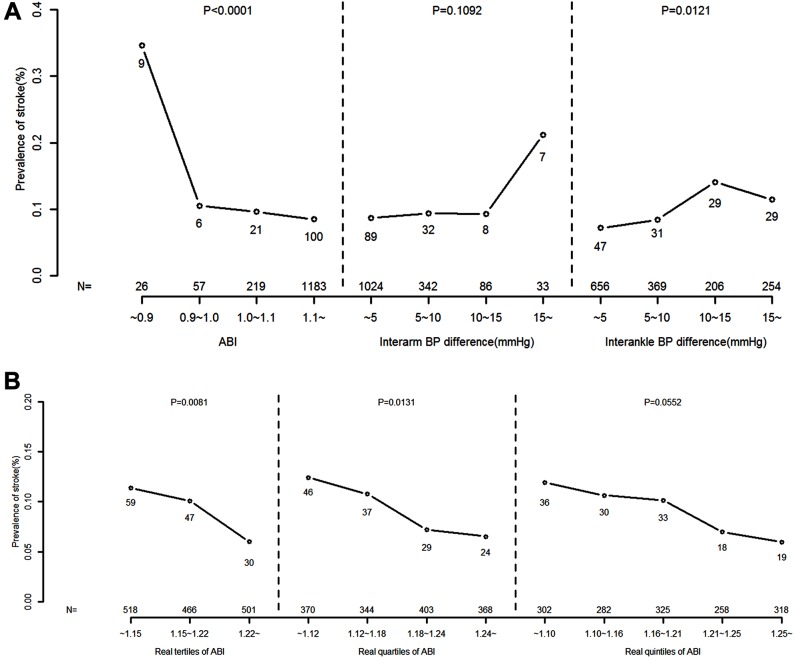
Prevalence of stroke stratified by the ankle-brachial blood pressure index (ABI) and interarm and interankle blood pressure (BP) differences.The numbers of strokes and participants are given alongside the symbols and at the bottom, respectively. P-values are given for trends in each group. A: The prevalence of stroke for different cutoff points of the ABI, interarm BP difference and interankle BP difference. Open circles represent the prevalence of stroke for ABI (left), interarm BP difference (middle) and interankle BP difference (right). B: The prevalence of stroke stratified according to real tertiles/quartiles/quintiles of the ABI distribution. Open circles represent the prevalence of stroke for real tertiles (left), quartiles (middle) and quintiles of the ABI distribution (right).